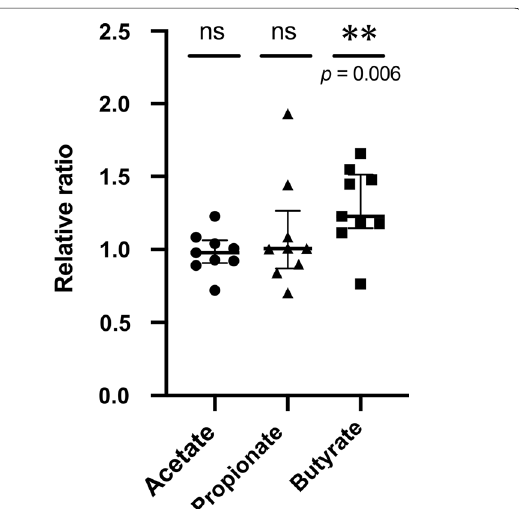
Fig. 5 Changes in the production of SCFAs. The ratio of SCFAs concentrations in the KUHIMM cultures with 1.5% YBL to those without 1.5% YBL are shown. ** p < 0.01, n 9, using Dunnett’s test. = The data shown are presented as medians and interquartile ranges (25th–75th percentiles). ns not